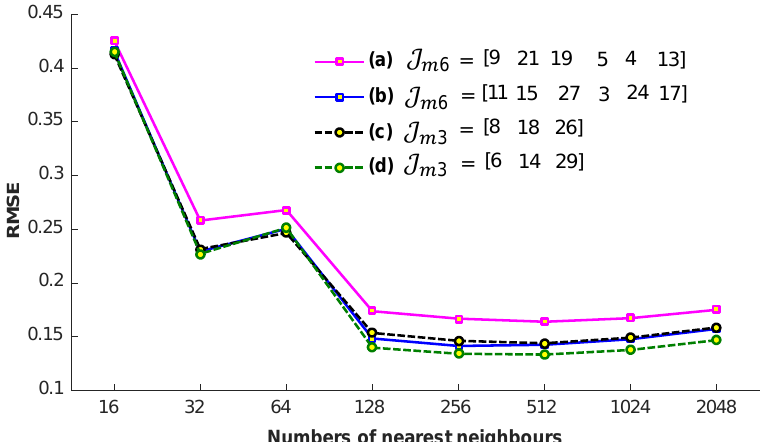
Figure 7. The impact of the number of nearest neighbors in terms of accuracy with different missing joint sets J m 6 and J m 3 .